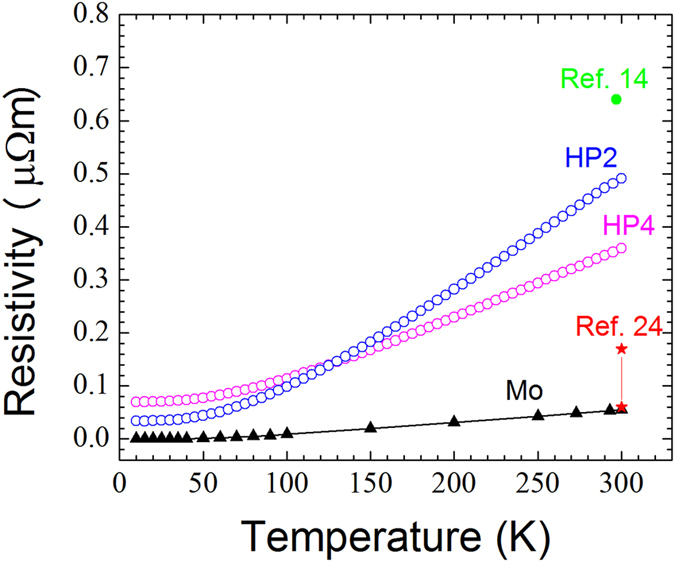
Resistivity vs. temperature of hot-pressed samples, MoAlB single crystals1424, and pure Mo metal23.